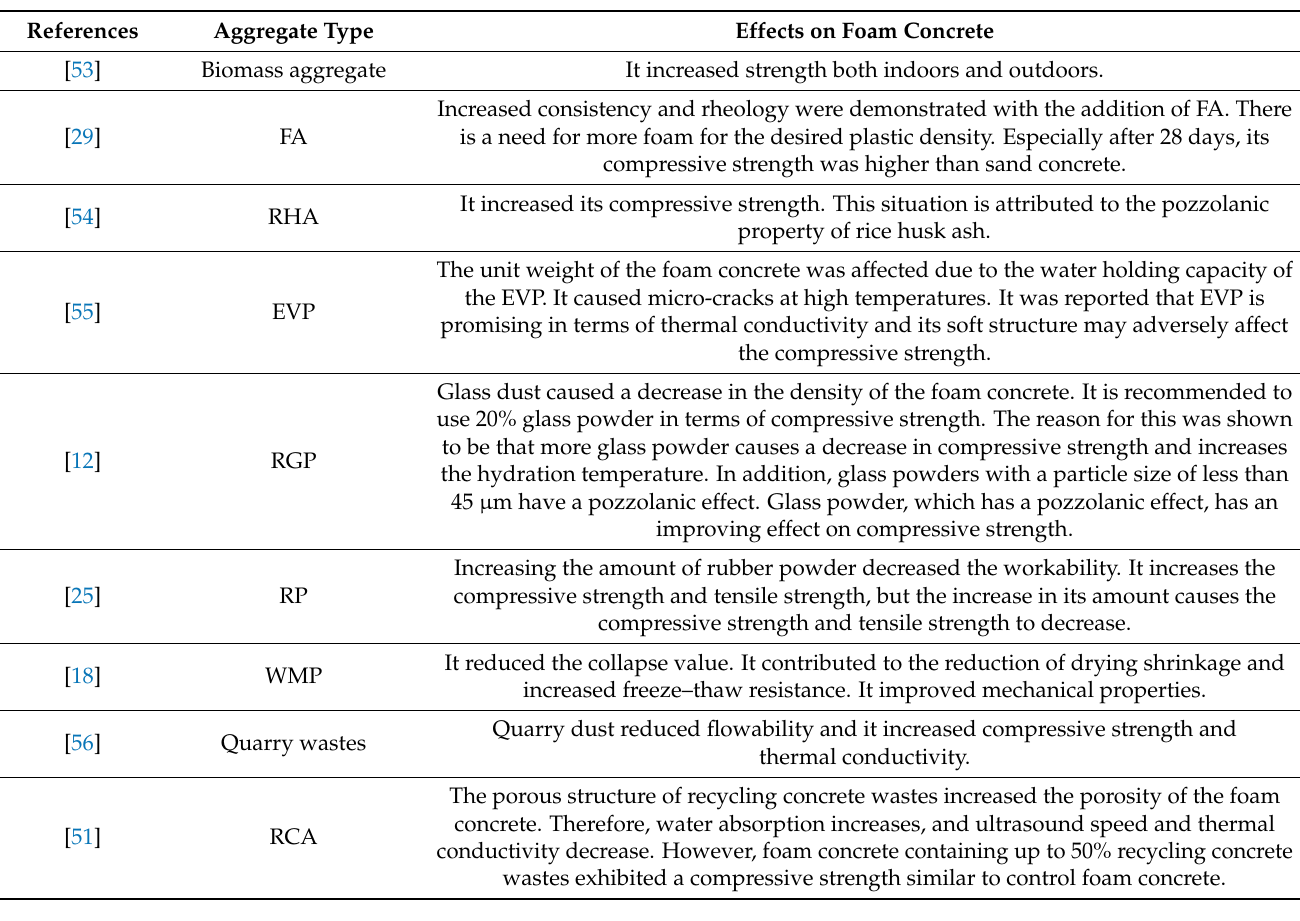
Table 2. Various types of